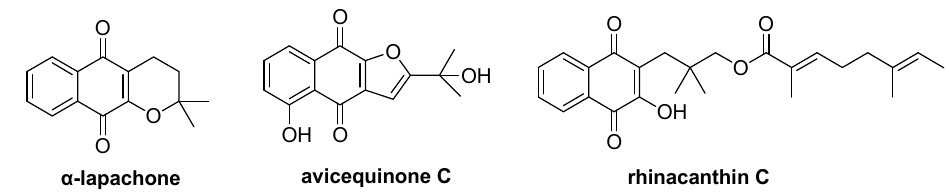
Figure 1. Structure of some natural 1,4-naphthoquinones.